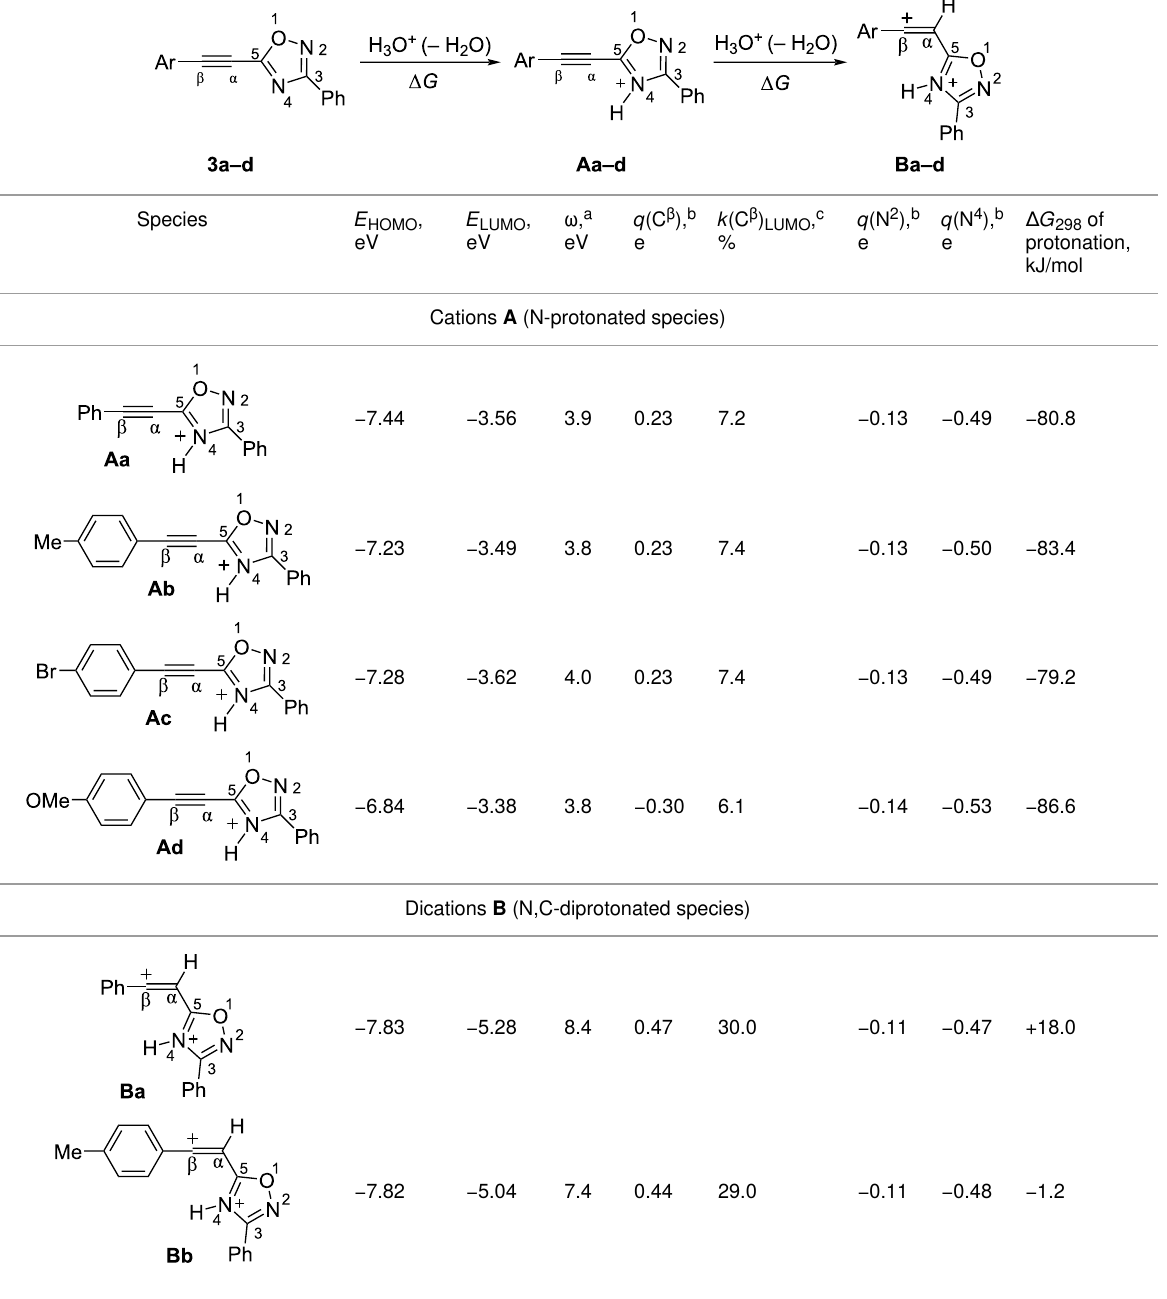
Table 1: Selected electronic characteristics for cations Aa–d and Ba–d calculated by DFT from protonation of oxadiazoles 3a–d .